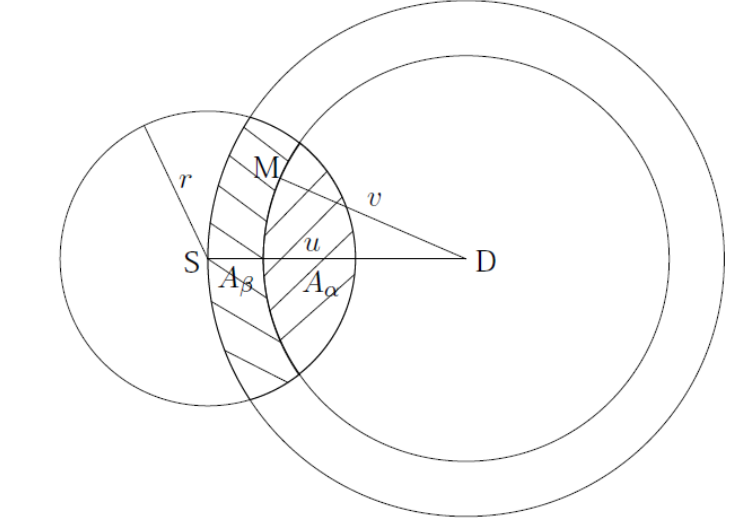
Figure 2. An illustration of the forwarding